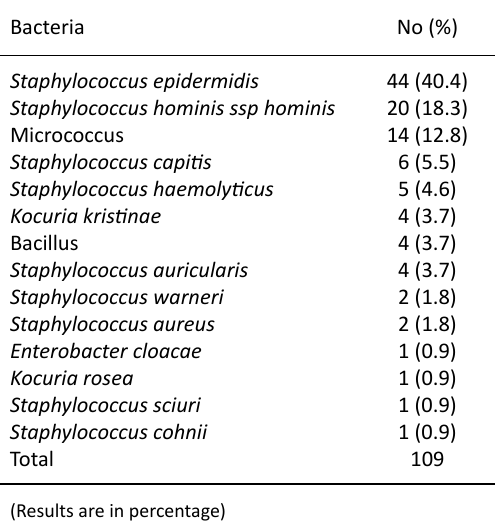
Table 2. Number of bacteria isolated from surfaces of mobile